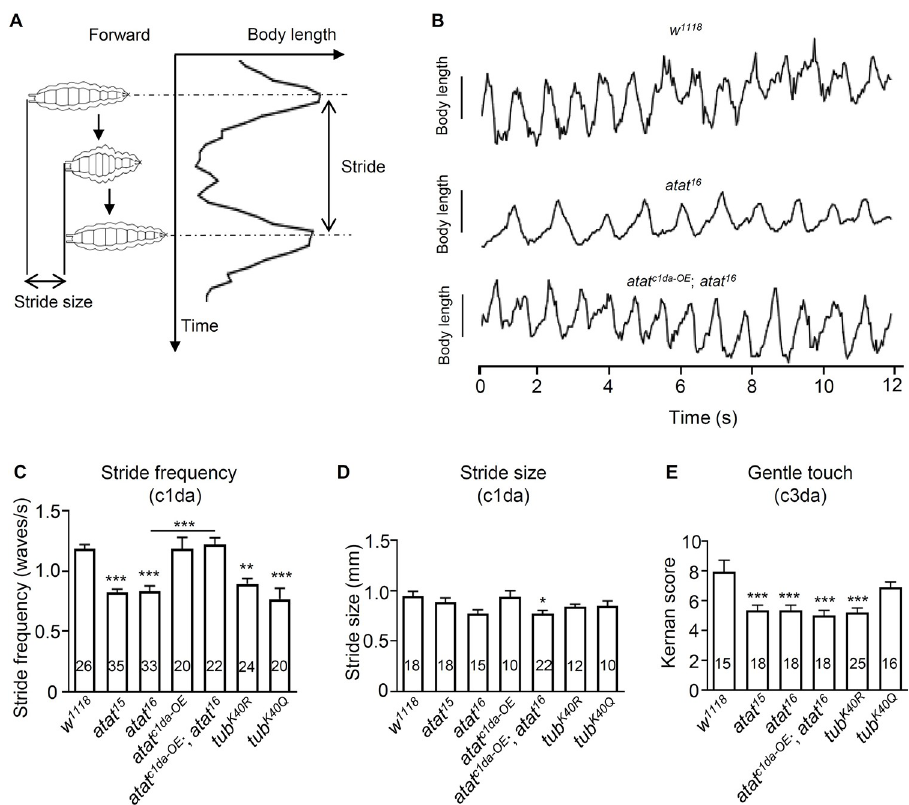
Fig 7. Tubulin K40 acetylation is required for larval locomotor control. (A) Schematic shows the peristaltic contractions during larval crawling. Stride frequency is defined as the number of peristaltic waves of muscle contraction per second, while stride size is the change of body length during one peristaltic wave. (B) Plots of larval body length (mm) over time (s) during larval crawling. atat c1da-OE , atat 16 : Atat overexpression by 221-Gal4 in atat 16 background. (C–E) Quantifications of the stride frequencies (C), the stride size (D), and gentle touch responses (E). Genotypes: control ( w 1118 ), atat 15 , atat 16 , Atat overexpression using 221-Gal4 ( atat c1da-OE ), Atat overexpression using 221-Gal4 in atat 16 mutant ( atat c1da-OE ; atat 16 ), α 1-tubulin K40R ( tub K40R ), and α 1-tubulin K40Q ( tub K40Q ). Mean ± SEM. One-way ANOVA with Tukey’s multiple comparisons test. ��� p < 0.001, � p < 0.05. ( Fig 7C ), supporting the role of α -tubulin acetylation in regulating larval locomotion. Muta- tions in atat or tubulin did not affect the stride size of larval crawling ( Fig 7B and 7D ), which is consistent with previous reports that class I da neurons mainly regulate the frequency but not the size of the strides [35]. We noticed that the reduction of stride frequency in atat and α 1-tubulin K40R mutants were smaller than depleting the mechanosensitive TRP channel NompC in class I da neurons [34], indicating that the functions of these neurons are only par- tially impaired when tubulin acetylation is depleted. In contrast to class I da sensory neurons that act as proprioceptor neurons, class III da sen- sory neurons control the behavioral responses to gentle touch stimuli [23, 36]. It has been shown that Atat-mediated tubulin acetylation in class III da neurons increases the sensitivity of touch perception [23]. Consistent with this notion, we found our atat and α 1-tubulin K40R mutants were less sensitive to gentle touch ( Fig 7E ). Re-expressing Atat in class I da neurons failed to restore the touch sensitivity defects in atat mutants ( Fig 7E ), further supporting that Atat is required for gentle touch sensitivity specifically in class III da neurons. Together, these results suggest that Atat and K40 acetylation are necessary for proper functions of both class I